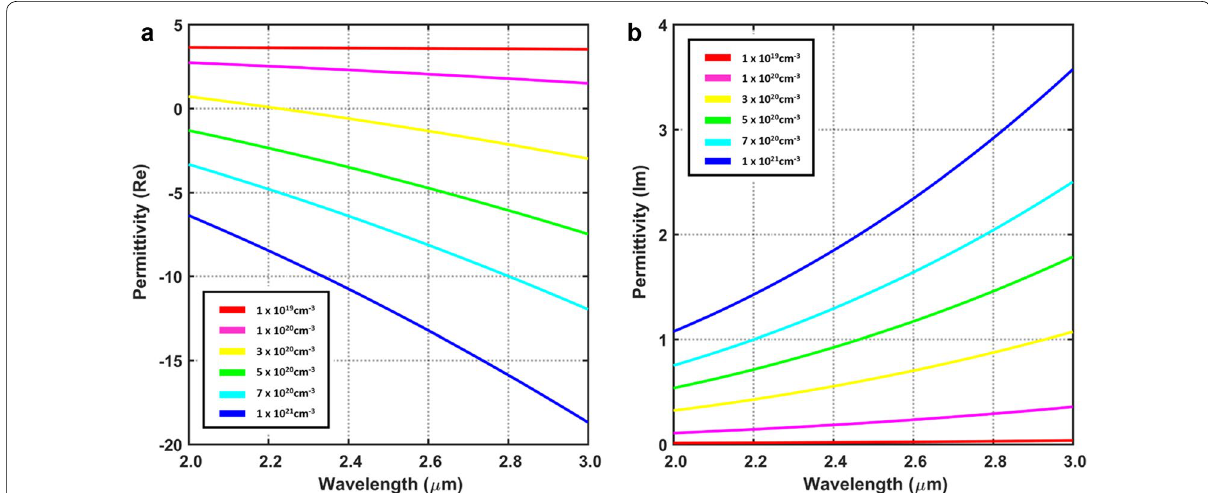
Fig. 4 Calculated permittivity of ITO according to the different carrier concentration from 10 19 to 10 21 cm − 3 , by Drude modelling of ITO. When volt- age was applied to the device, a the real and b imaginary parts of the complex permittivity vary concurrently and in opposite directions